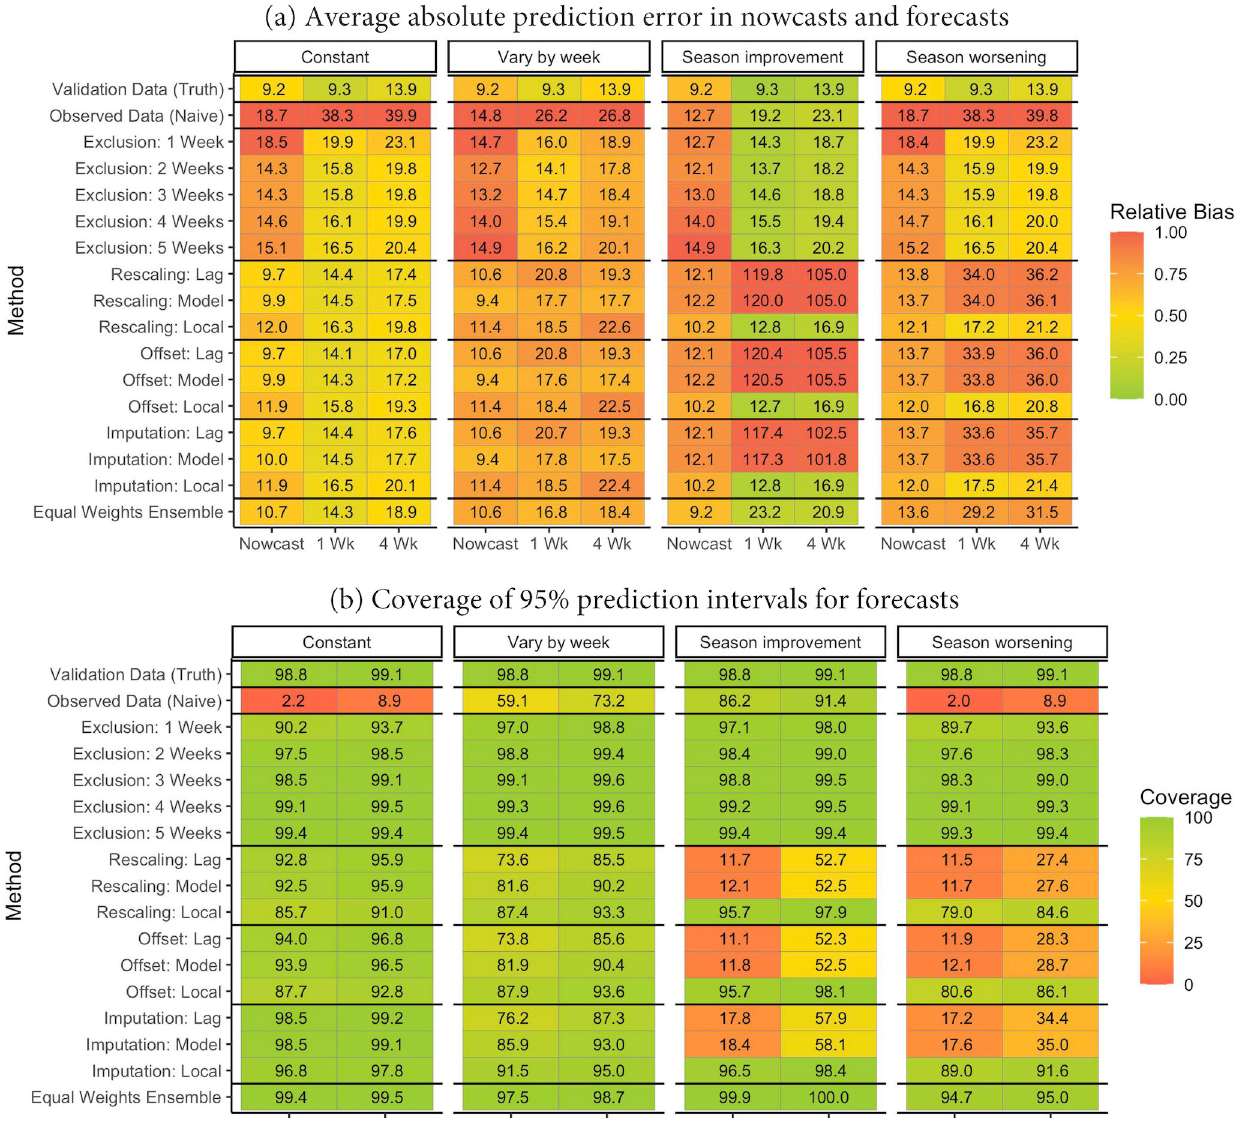
Fig 5. Performance of proposed methods for handling reporting delay in 2009 across 100 simulated datasets using ARMA models 1 . 1 Results are aggregated across all 50 weeks in 100 replicate seasons. Each result, therefore, represents aggregates 5000 nowcasts or forecasts. When reporting factors varied across seasons, π 2007 = π 2008 = (0.01, 0.05, 0.55, 0.85, 0.95, 0.98, 1) and π 2009 = (0.04, 0.54, 0.84, 0.0.94, 0.97, 0.99, 1). The ensemble method corresponds to an equal-weight linear combination of all methods except validation data analysis and exclusions of 4 and 5 weeks’ data. “Model” indicates that reporting factors were estimated via regression and allowed to vary by t and s . “Lag” indicates that reporting factors were estimated via Eq 6. “Local” indicates that reporting factors were estimated via Eq 8. Relative absolute biases are calculated relative to the largest value in each column. Model-based π assumes reporting factors vary across weeks but incorrectly models how reporting factors vary across